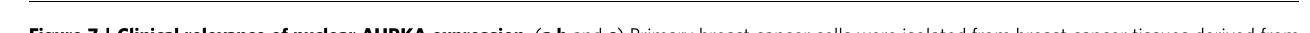
Figure 7 | Clinical relevance of nuclear AURKA expression. ( a , b and c ) Primary breast cancer cells were isolated from breast cancer tissues derived from ten patients. Nuclear and cytoplasmic fractions were subjected to immunoblotting (IB) analysis ( a ). The expression of CD24 and CD44 were analysed using flow cytometry ( b ). Nuclear and cytoplasmic fractions of AURKA were normalized using histone H3 and b -actin, respectively. The nuclear fraction of c-Myc and hnRNP K were normalized using histone H3. The normalized AURKA, c-Myc, hnRNP K and the CD24 low /CD44 high population derived from the same patient were used to compose a scatterplot and linear regression analysis performed ( c ). ( d ) Breast cancer tissues were subjected to IHC staining for indicated antibodies. Representative images were acquired with (cid:2) 10 and (cid:2) 40 objectives (upper panel). Scale bar, 50 m m. Pearson’s w 2 -test was used to analyse the correlation between nuclear AURKA and c-Myc/CD24 (lower panel). ( e ) IHC staining for AURKA and c-Myc was performed on breast cancer tissues. Kaplan–Meier analysis was performed and log-rank test used to make statistical comparisons. ( f ) During breast cancer development, AURKA is overexpressed and translocates to the nucleus, where the nuclear AURKA acts as a transactivating factor that binds and activates the MYC promoter through its interaction with hnRNP K. Through these mechanisms, nuclear AURKA enhances BCSC phenotype. Importantly, these processes are dependent on the nuclear localization of AURKA rather than its kinase activity. Traditional targeted therapies focus on the inhibition of kinase activity, which may be insufficient for suppressing the kinase-independent oncogenic actions. These new findings suggest that targeting the spatial deregulation of kinase could be a promising strategy for overcoming kinase inhibitor